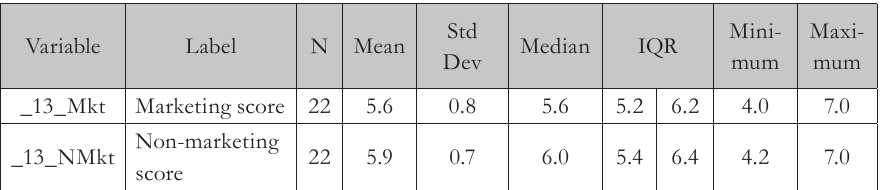
Tab. 2 – BI Managers Marketing and non-Marketing own skills set scores compared. Source: